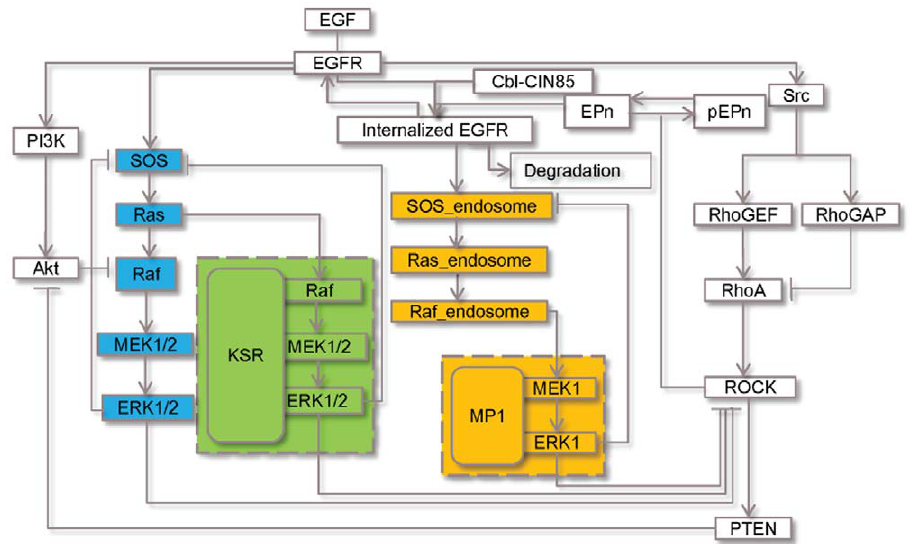
Figure 1. A model for Ras/ERK signaling pathway regulated by scaffolds and modulators. More detailed biochemical model of scaffolding actions of KSR and MP1 in the dashed rectangular boxes are shown in Figures 2 and 3, respectively. Molecules highlighted in blue , green and orange boxes represent the separate modules of Ras/ERK signaling operating from the conventional mode (no-scaffolds; membrane), KSR-supported mode (membrane) and MP1-supported mode (late endosome), respectively.